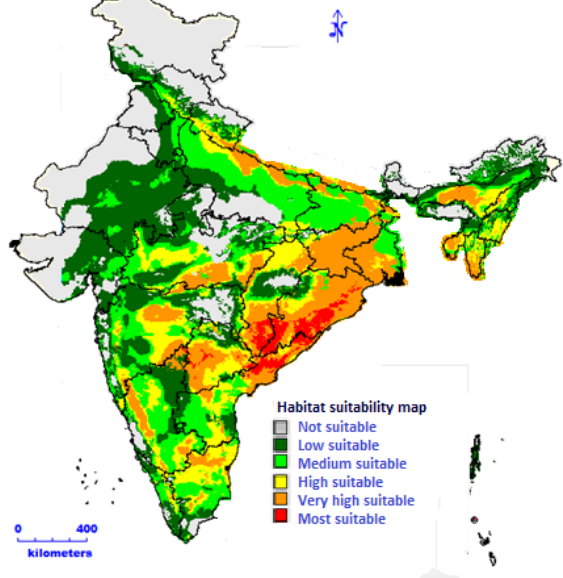
Figure 8. Predicted areas for additional ex-situ conservation of the priority Vigna species. Being an excellent soil conservation crop, V. adenantha has a twinning or trailing perennial herb, a tuberous rootstock, and pinkish-violet flowers. It is distributed mainly in the A&N Islands, Bihar, Madhya Pradesh, Odisha, Tamil Nadu, and West Bengal. Collections of V . glabrescens were made from Jharkhand and Uttar Pradesh, while distributions have been recorded in parts of Odisha and West Bengal. An extensive survey and collection of germplasm are required to establish new distribution records. It is a robust, erect herb with large golden-yellow flowers. V. minima was collected from the Goa part of the Western Ghats and is also distributed in China, Malaysia, Japan, and New Guinea. V. marina , also known as beach pea, is a prostrate, creeping vine that is a perennial species of coastal regions. The flowers are yellow and have a pea-like shape. In India, it is distributed in Nicobar and the south Andaman Islands, particularly in hot humid to sub-humid ecological subregions with shallow to medium depth loamy to clayey red and red loamy soil in coastal regions of the country [37]. Vigna stipulacea has mostly been collected from parts of Andhra Pradesh, a peninsular part of southern India. High humidity and temperature are necessary for its growth, which makes it a preferred fodder legume in both summer and rainy